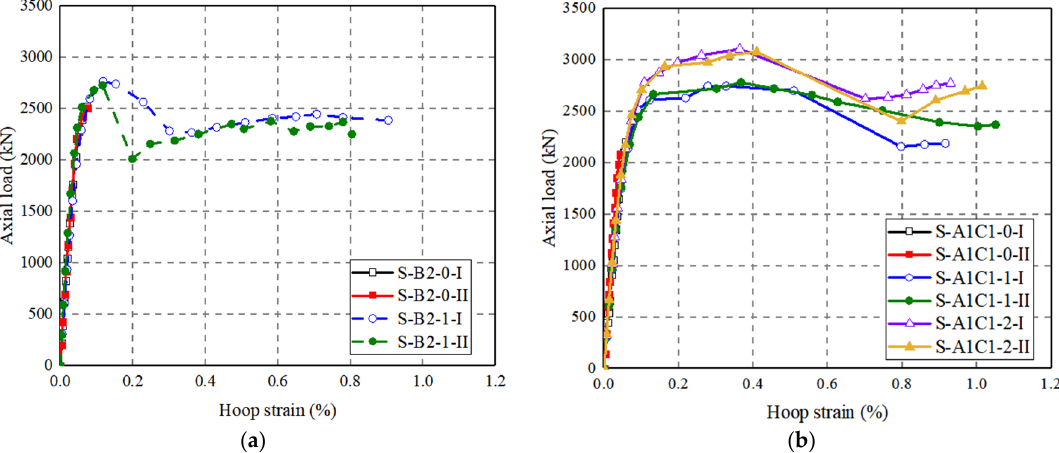
Figure 16. Effect of number of the FRP layers on axial load–hoop strain curves of CFRP-confined concrete-filled FRP-grid UHPC tube columns. ( a ) Position B; ( b ) Position AC.